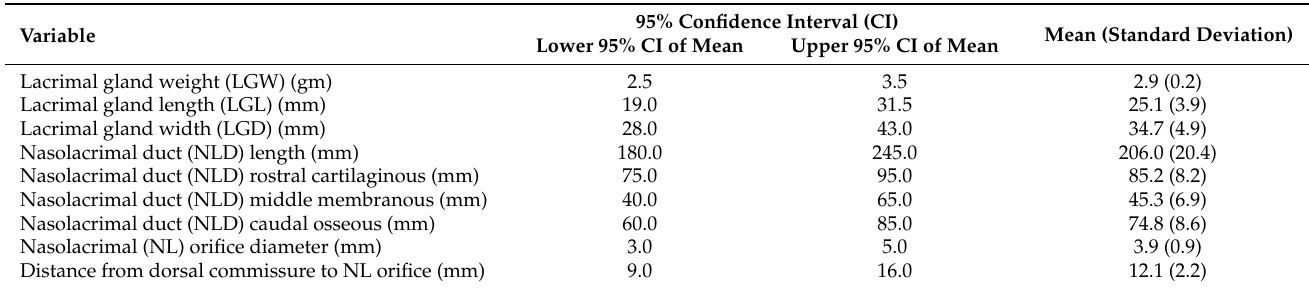
Table 2. Descriptive statistical analysis of gross-derived lacrimal apparatus measurements of clinically normal dead